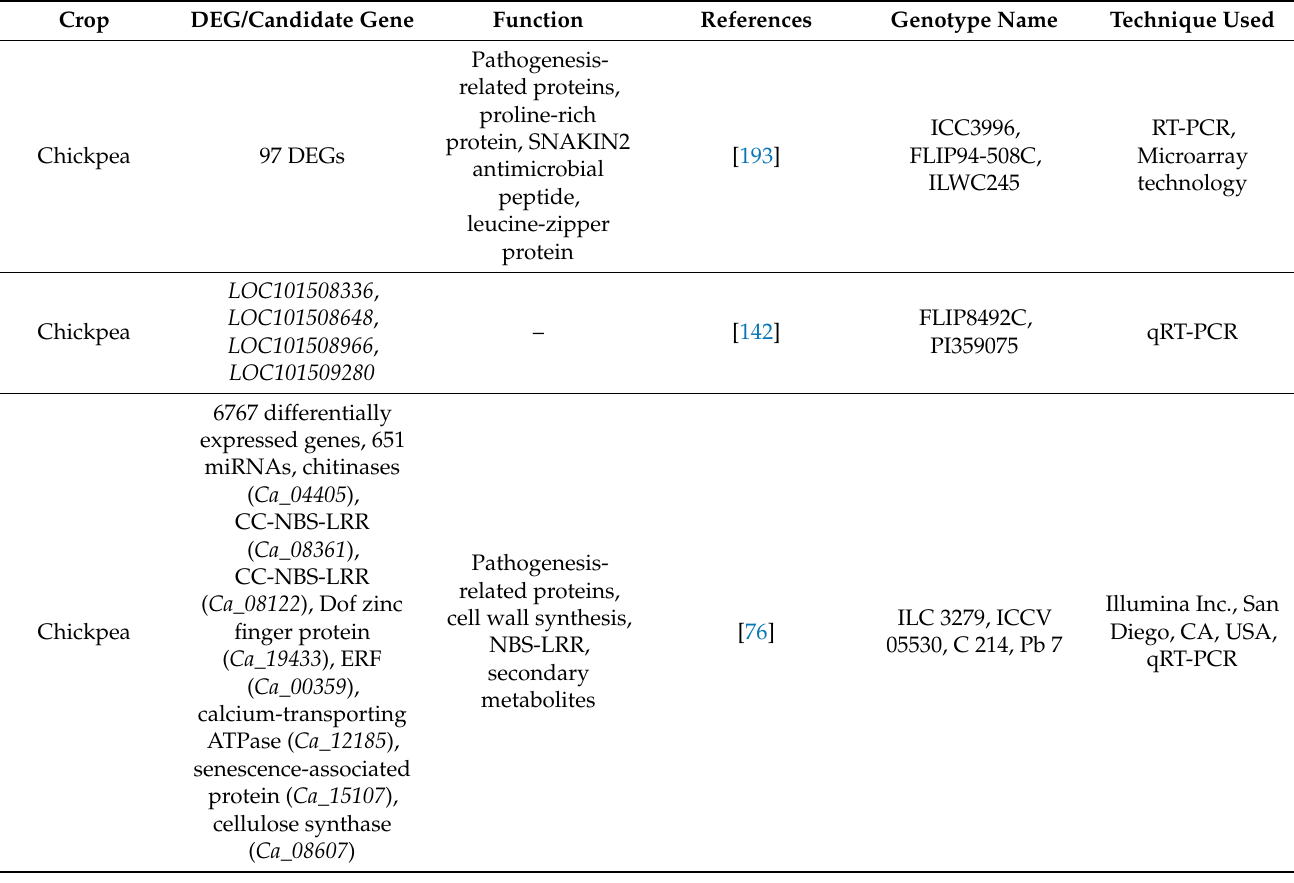
Table 4. Differentially expressed genes (DEGs)/candidate genes associated with ascochyta blight resistance in grain legumes along with putative